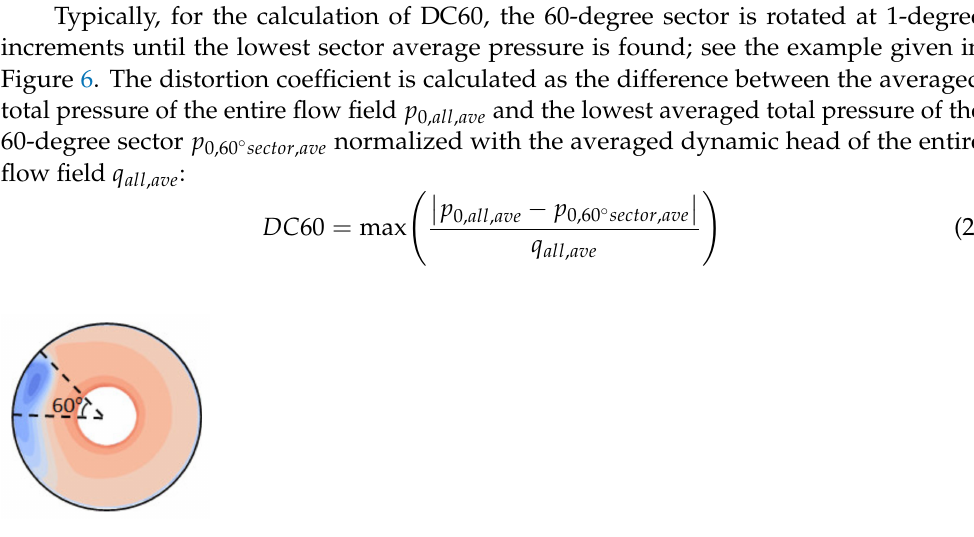
Figure 6. Illustration of the 60-degree sector used in the distortion severity calculation method.